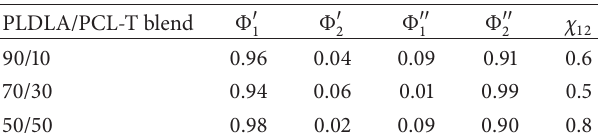
Table 2: Interaction parameters for different PLDLA/PCL-T blends. PLDLA/PCL-T blend